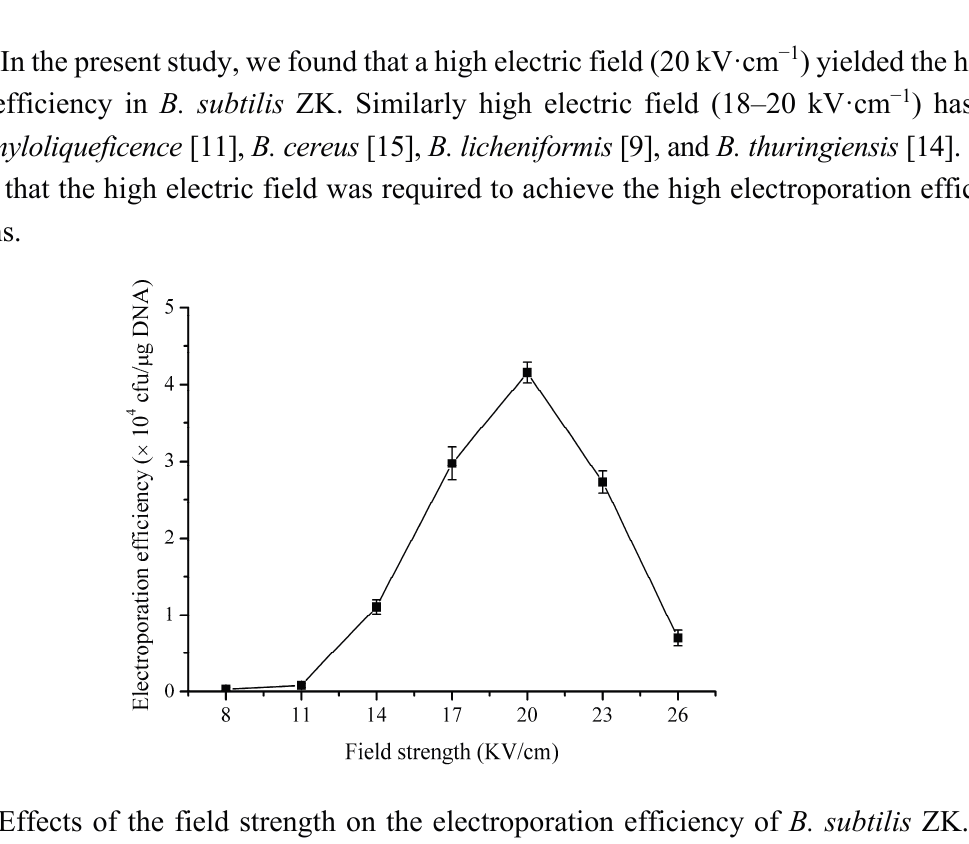
Figure 2. Effects of the field strength on the electroporation efficiency of B. subtilis